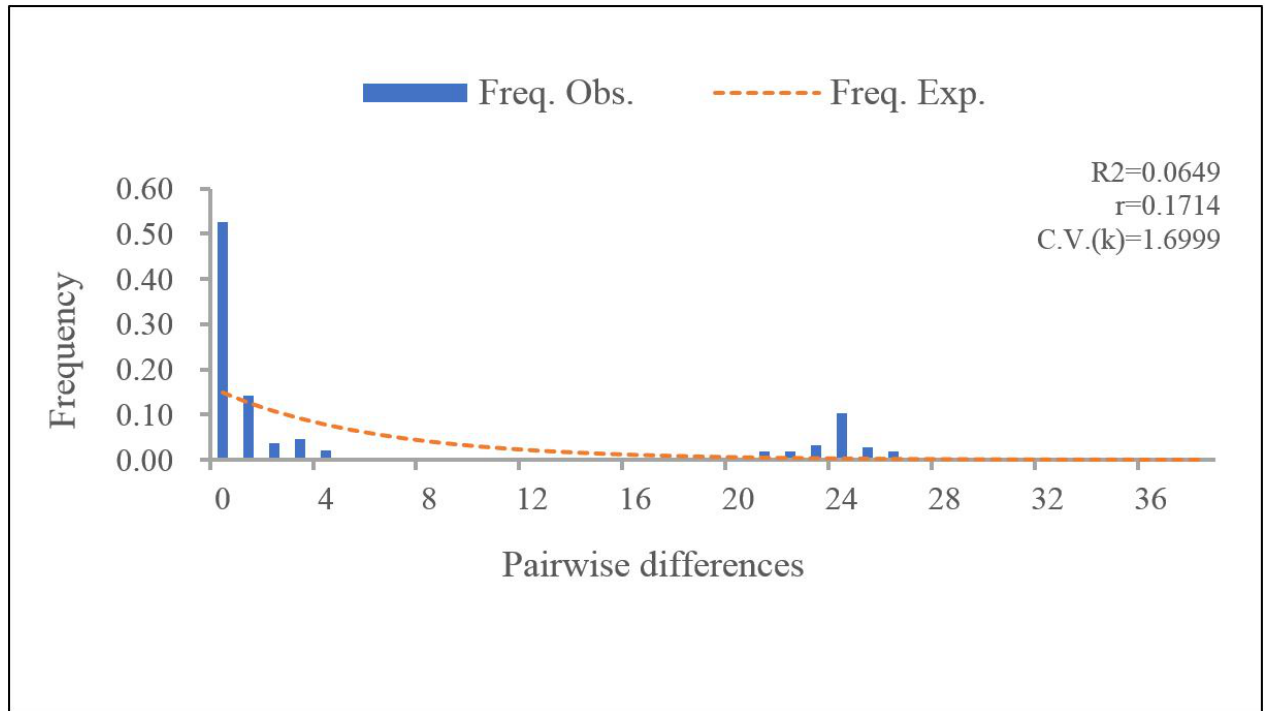
Figure 2. Pairwise mismatch distributions for 105 PaWB phytoplasma strains, based on the concate- nated sequences by DnaSP software. The X -axis shows the observed distribution of pairwise genetic variation, and the Y -axis represents the